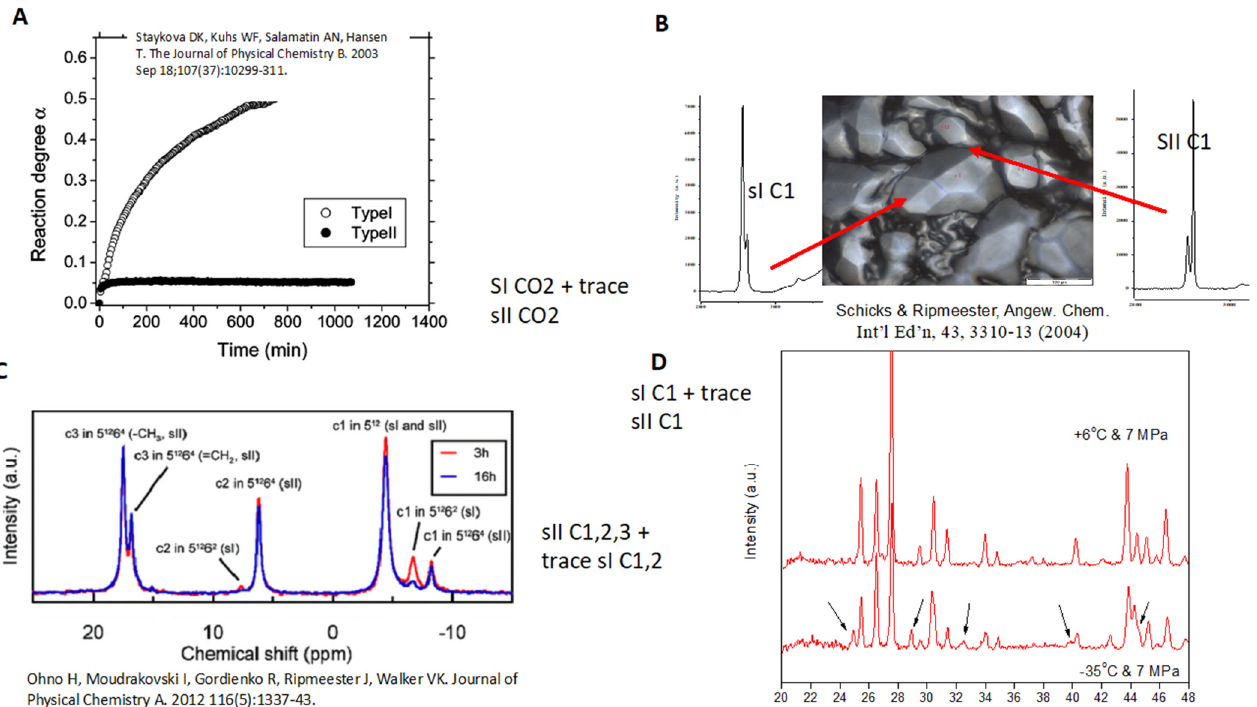
Figure 2. Spectroscopic data from Canadian NRC ( C , D ), U. Göttingen ( A ) and GFZ Potsdam ( B ), showing metastable hydrate phases after two days (Ripmeester [23]).